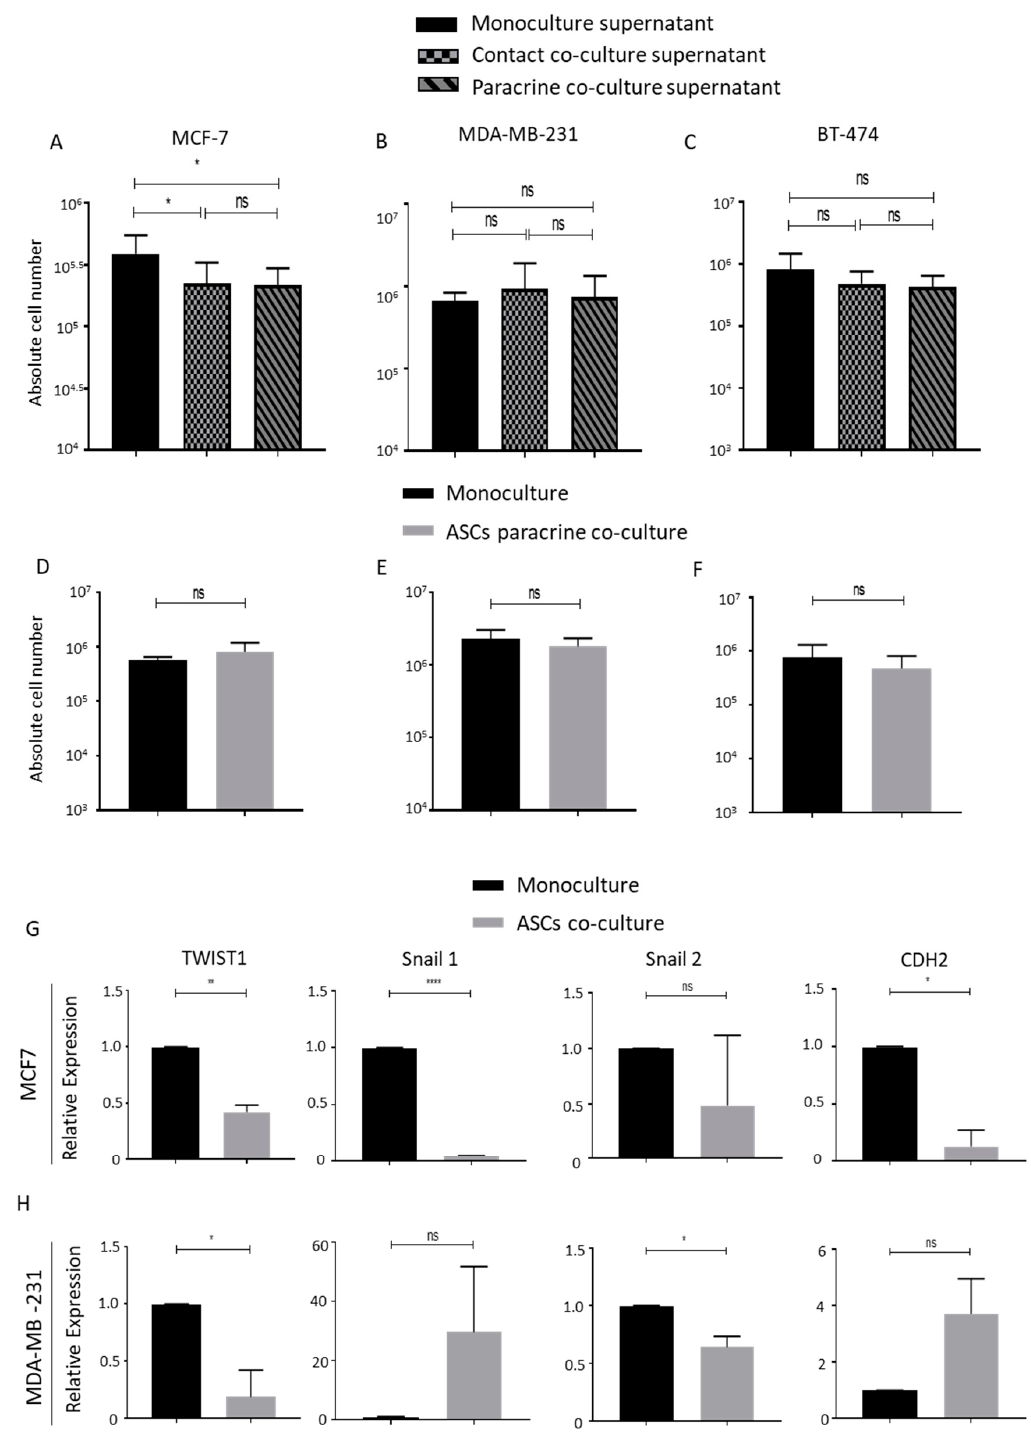
Figure 3. Transwell paracrine culture of ASCs does not promote breast cancer cells proliferation. ( A – C ) Absolute cell count obtained using Neubauer counting chamber after 4 days of culture of either MCF-7 ( A ), MDA-MB-231 ( B ) or BT-474 ( C ), in cell culture supernatant collected from either monocultured, contact-co-cultured or paracrine-cultured breast cancer cells with lipoaspirates. Graphs are representative of 3 independent experiments. ( D – F ) Representative graph of cell count of MCF-7 ( D ), MDA-MB-231 ( E ) and BT-474 ( F ) cell upon transwell co-culture with ASCs. ASCs from 3 di ff erent donors were employed. ( G , H ) Relative EMT genes expression of monocultured or co-cultured MCF-7 ( G ) and MDA-MB-231 ( H ) was analyzed by quantitative real-time PCR. p value < 0.05 = *, p < 0.01 = **, p < 0.0001 = ****, ns =